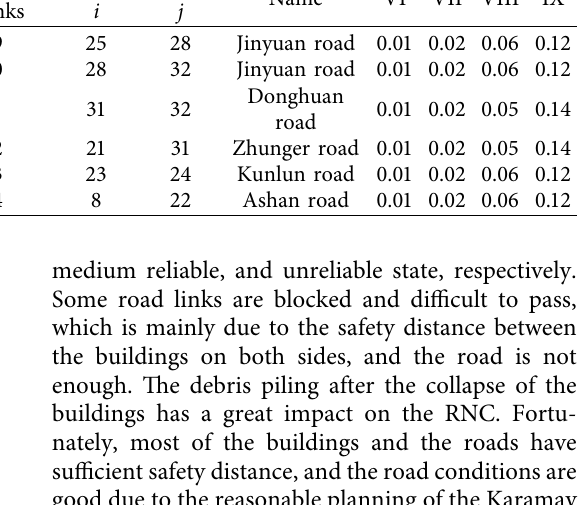
Table 10: Damage state of elements in the network.